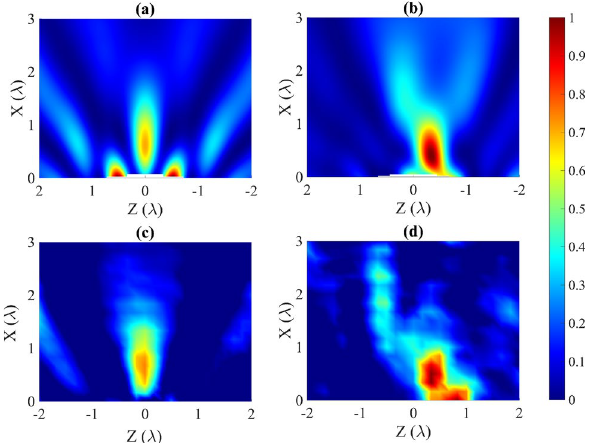
Figure 5. Normalized intensity planes ( I / I max ) for R = 4 (cid:31) ABS cylinders. ( a , b ) correspond to numerical solutions with and without embedded 9 × 9 PhC rotated θ = 15 ◦ , respectively. ( c , d ) correspond to experimental measurements for same cases stated before.